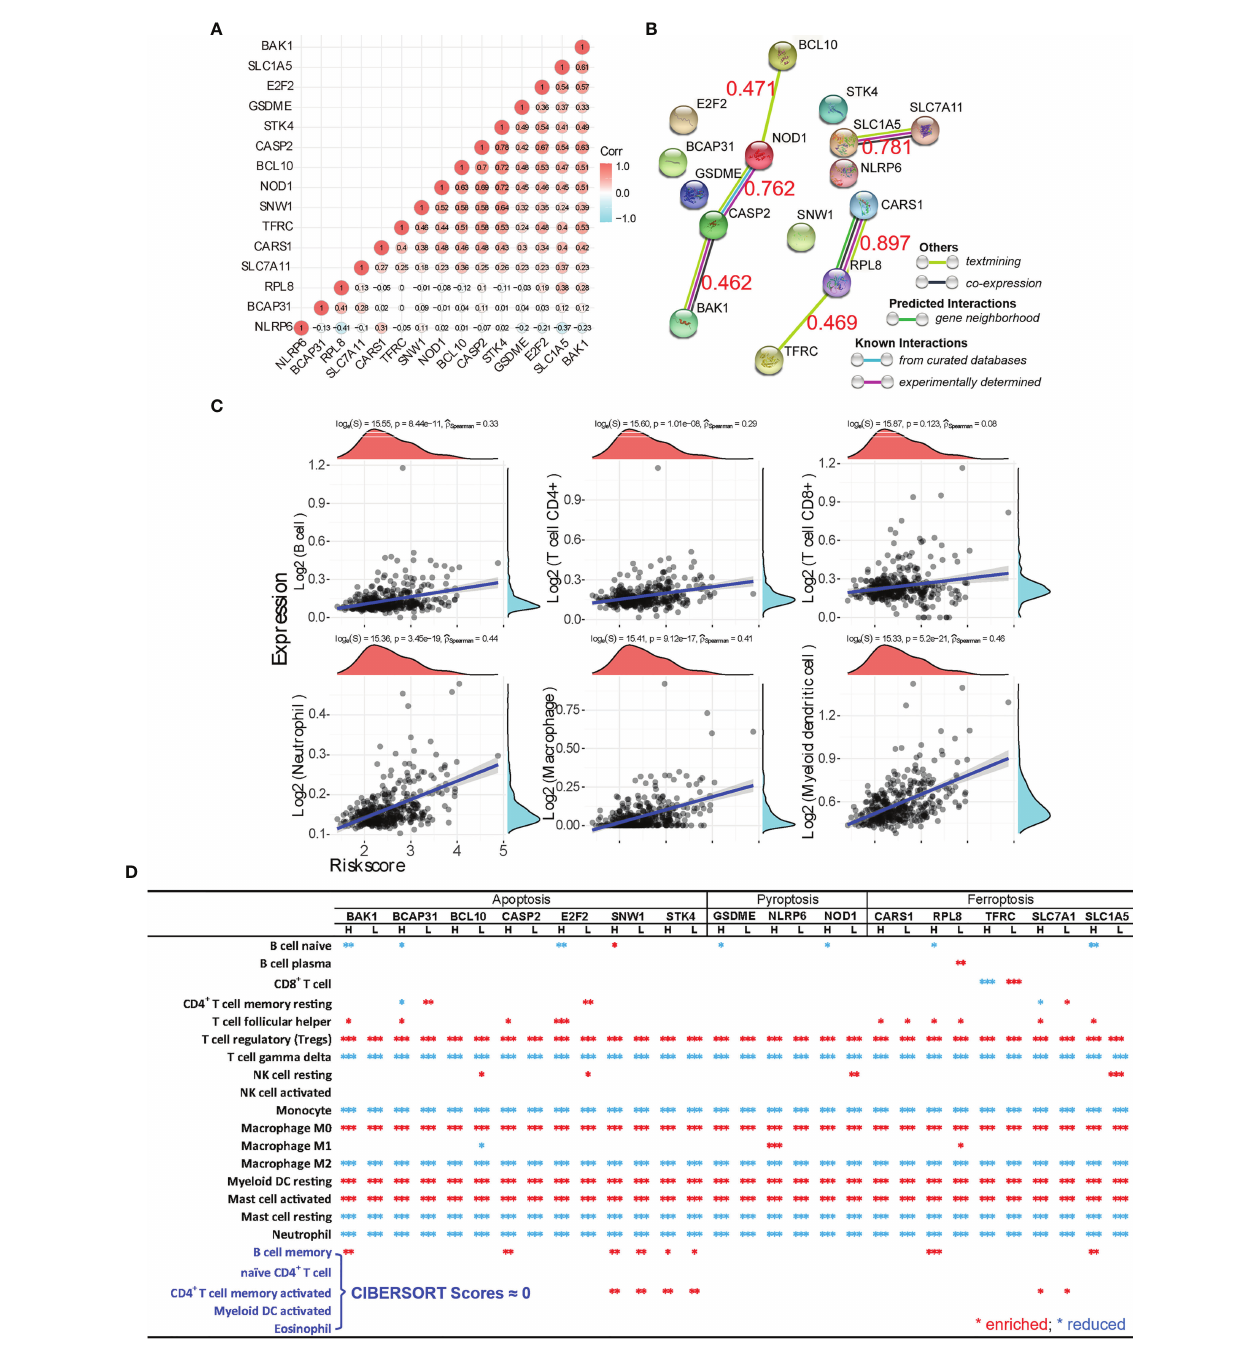
FIGURE 5 | Marker gene cross-talking analysis of apoptosis, ferroptosis, and pyroptosis. (A) The gene-gene correlation of all “ -optosis ” marker genes that have signi fi cant correlations with the overall survival (OS) (p < 0.01) is analyzed. The correlation coef fi cient is shown on each circle, and the red circle refers to a positive correlation, while the blue one means a negative correlation. (B) Using the analysis tool provided by the STRING database, the interaction of protein corresponding to each “ -optosis ” marker gene was calculated as well, and the correlation coef fi cient between genes is marked as red numeric. (C) Spearman ’ s correlation analysis between the risk score of the prognostic model (calculated from the 15 “ -optosis ” marker genes, BCL10, E2F2, BAK1, BCAP31, CASP2, SNW1, STK4, SLC1A5, CARS1, SLC7A11, RPL8, TFRC, GSDME, NLRP6, and NOD1) and immune score. (D) Using the CIBERSORT analysis, the comprehensive relationship between the expression of each “ -optosis ” marker gene (p < 0.01 correlating with the OS) and immune cell in fi ltration is revealed. The red asterisk means enriched in fi ltration, and the blue one means reduced in fi ltration of immune cells. *p < 0.05; **p < 0.01; ***p <